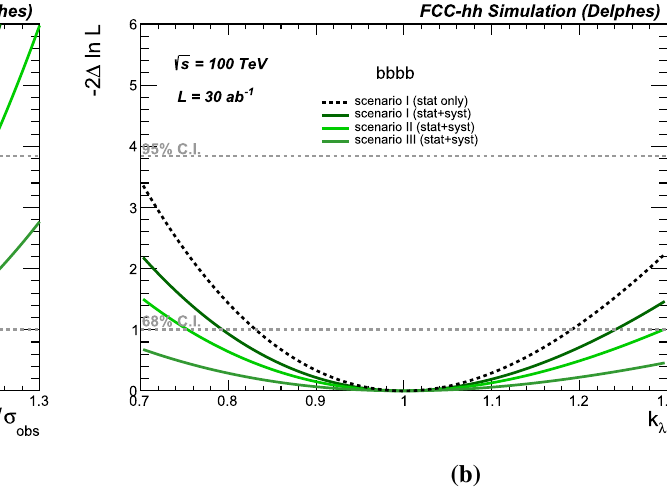
different systematic uncertainties assumptions summarized in Table 3. The black dashed line shows the likelihood profile when onlythe statis- tical uncertainty is included under scenario